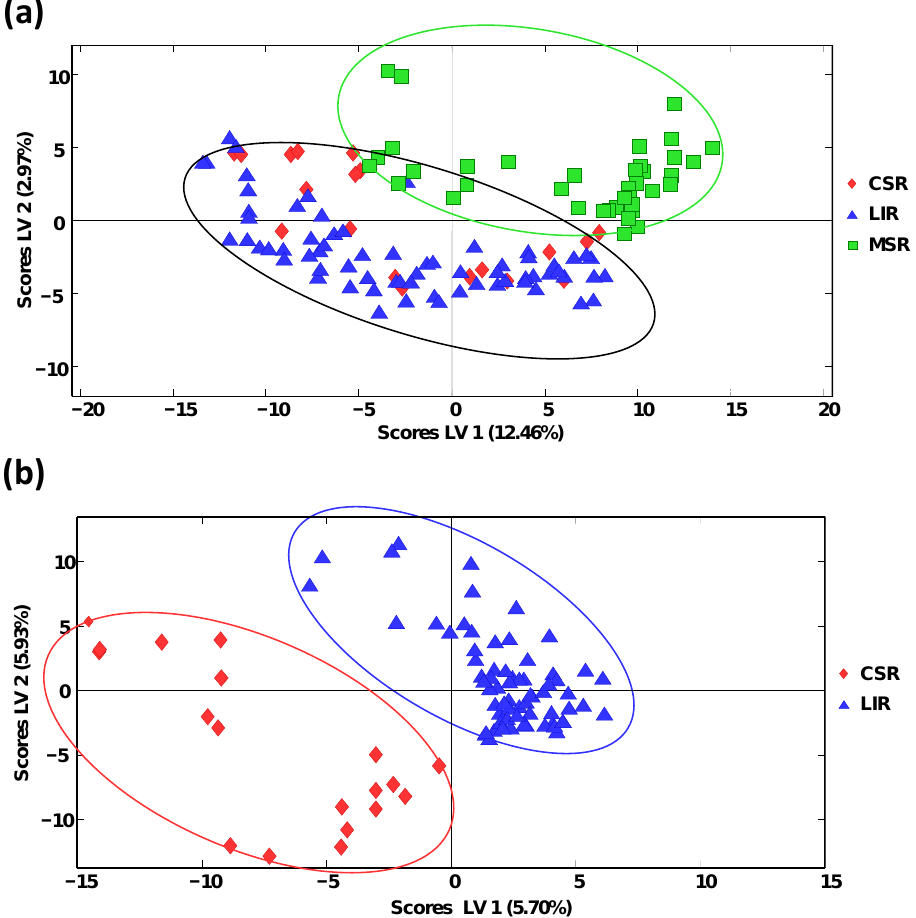
Figure 5. Partial least squares-discriminant analysis (PLS-DA) score plots when using off-line SPE HPLC-LRMS fingerprints as honey chemical descriptors for the classification ( a ) based on their climatic geographical production regions (LV1 vs. LV2 score plot, 2 LVs were used to build the model) and ( b ) CSR and LIR honey samples (LV1 vs. LV2 score plot, 2 LVs were used to build the model). CSR: Cantabrian Sea region; LIR: Landlock Inland region; and MSR: Mediterranean Sea region. Nevertheless, a paired PLS-DA model employing only the samples belonging to the LIR and CSR groups (Figure 5b) showed perfect discrimination of these two honey sample groups, demonstrating that the proposed fingerprints were feasible to classify the honey samples under study according to their climatic geographical production region, at least when employing a sequential PLS-DA classification